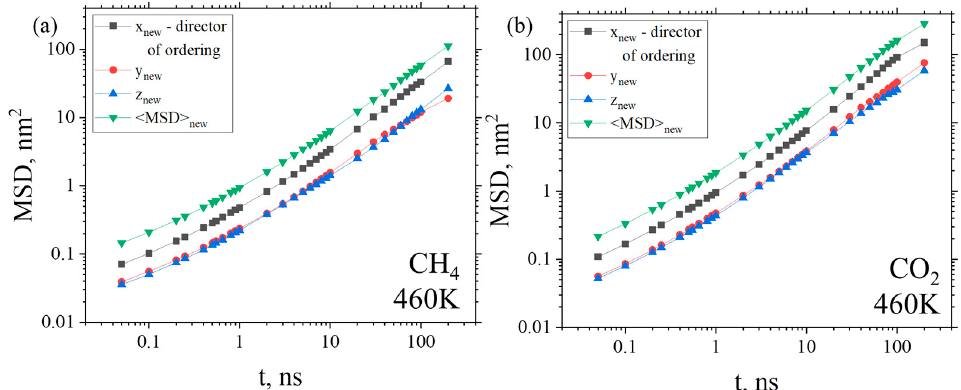
Figure 8. Time dependence of MSD for ( a ) CH 4 and ( b ) CO 2 gases in an ordered state for BPDA-P3 along the “new” axes: the one axis corresponds to the direction of ordering (black curve) and the two other axes are perpendicular to the first (red and blue curve). The green curve denotes the total MSD as the sum of MSD along three components (x new , y new and z new ) in the “new” coordinate system. The graphs presented correspond to the system obtained after 29 μ s of simulations (ordered state) at cooling to T = 460 K.